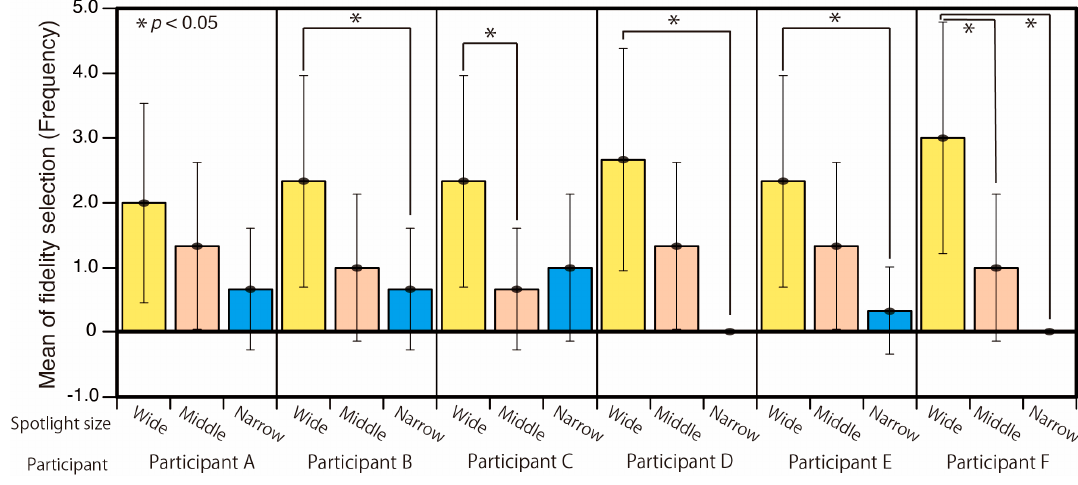
Figure 9. Result of fidelity selection for each participant.